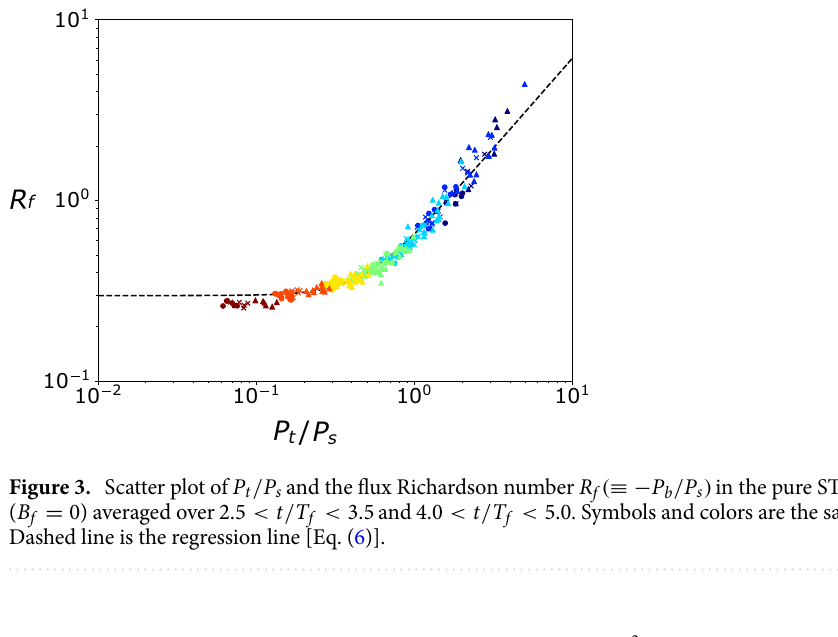
Figure 3. Scatter plot of P t / P s and the flux Richardson number R f ( 0 ) averaged over 2.5 < t / T ( B f = Dashed line is the regression line [Eq.